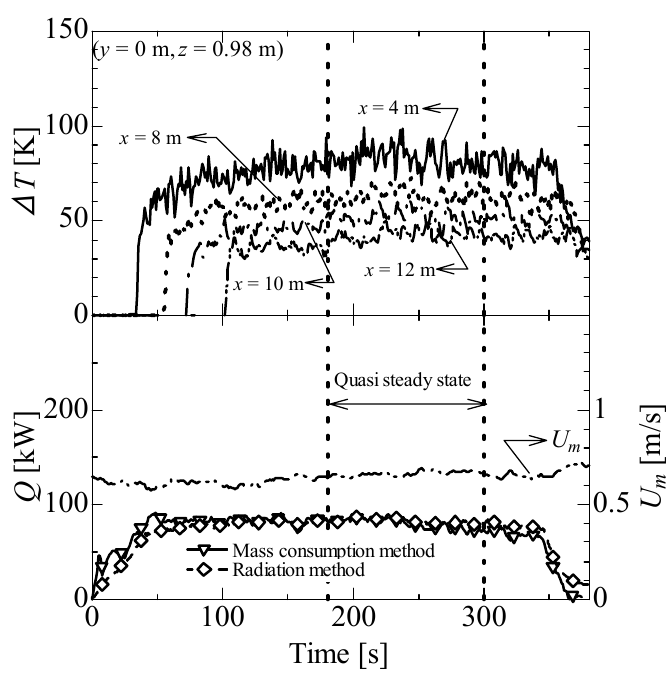
Fig. 4 Time curves of the heat release rate, ventilation velocity, and temperature rise at thermocouples in four different positions: x = 4, 8, 10, 12 m, y = 0 m, z = 0.98 m, in the case of the burning area A f = 0.079 m 2